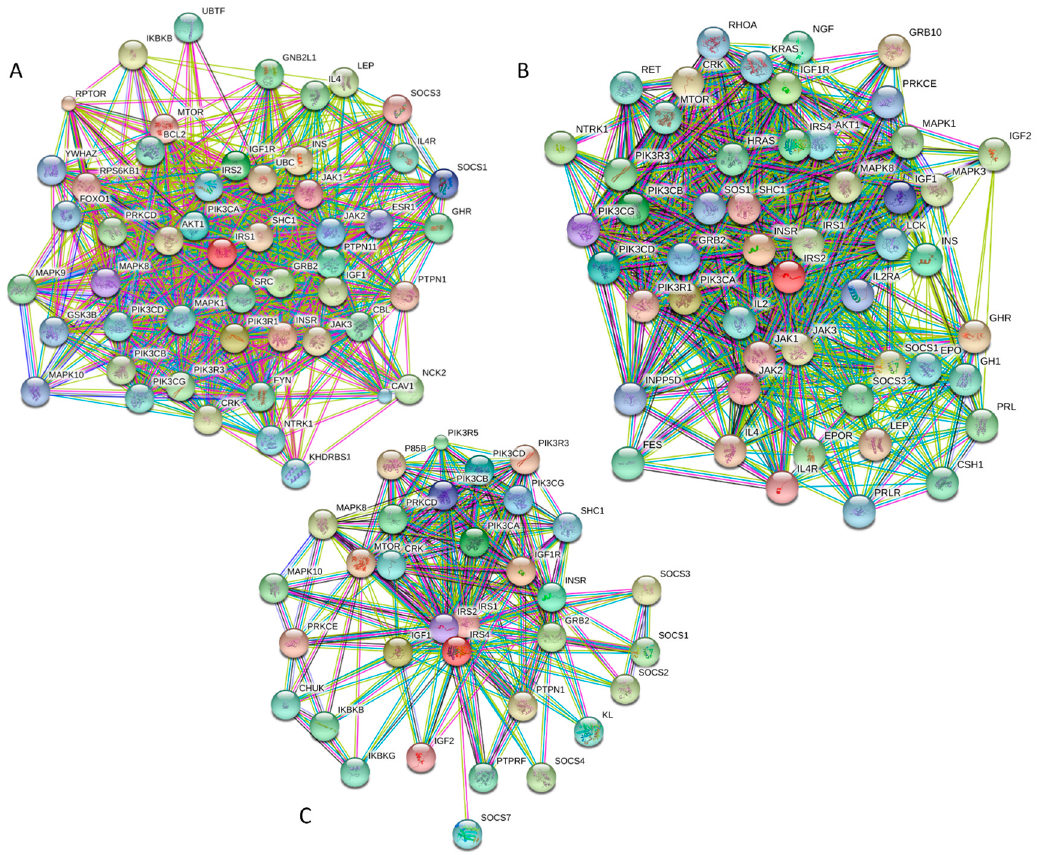
Figure 9. Analysis of the interactivity of human IRS1 ( A ), IRS2 ( B ), and IRS4 ( C ), by STRING computational platform.